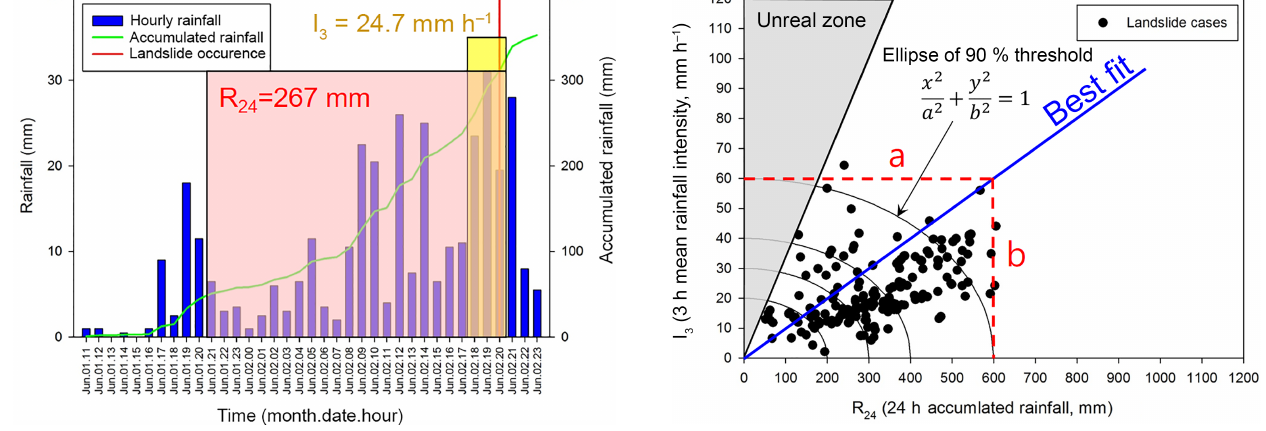
Figure 3. The 3h mean rainfall intensity ( I 3 ) and 24h accumu- lated rainfall ( R 24 ) were used as short-term and long-term rainfall indexes for the establishment of rainfall thresholds.